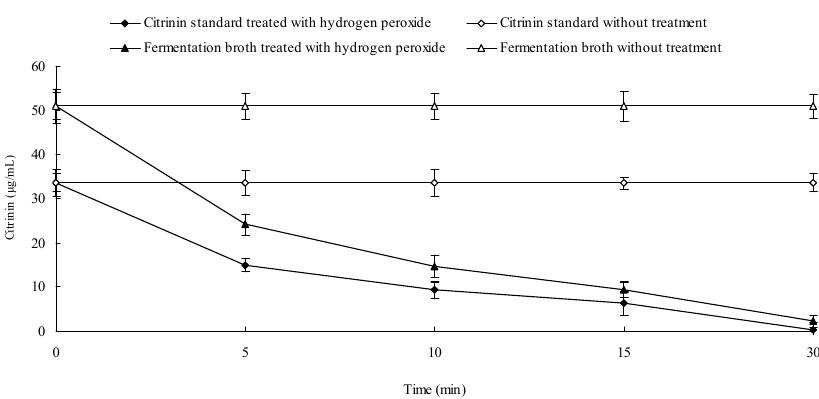
Figure 9. Effect of H 2 O 2 on citrinin stability. Hydrogen peroxide solution (0.05 mL, 30%) was respectively added to 3.6 mL citrinin standard methanol solution and citrinin extraction solution of Monascus fermentation broth. Citrinin content was determined by HPLC at regular time intervals.